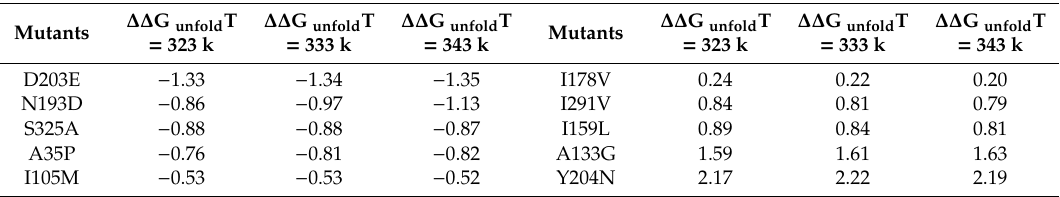
Table 1. The ∆∆ G unfold (kcal · mol − 1 ) of the 10 mutants.